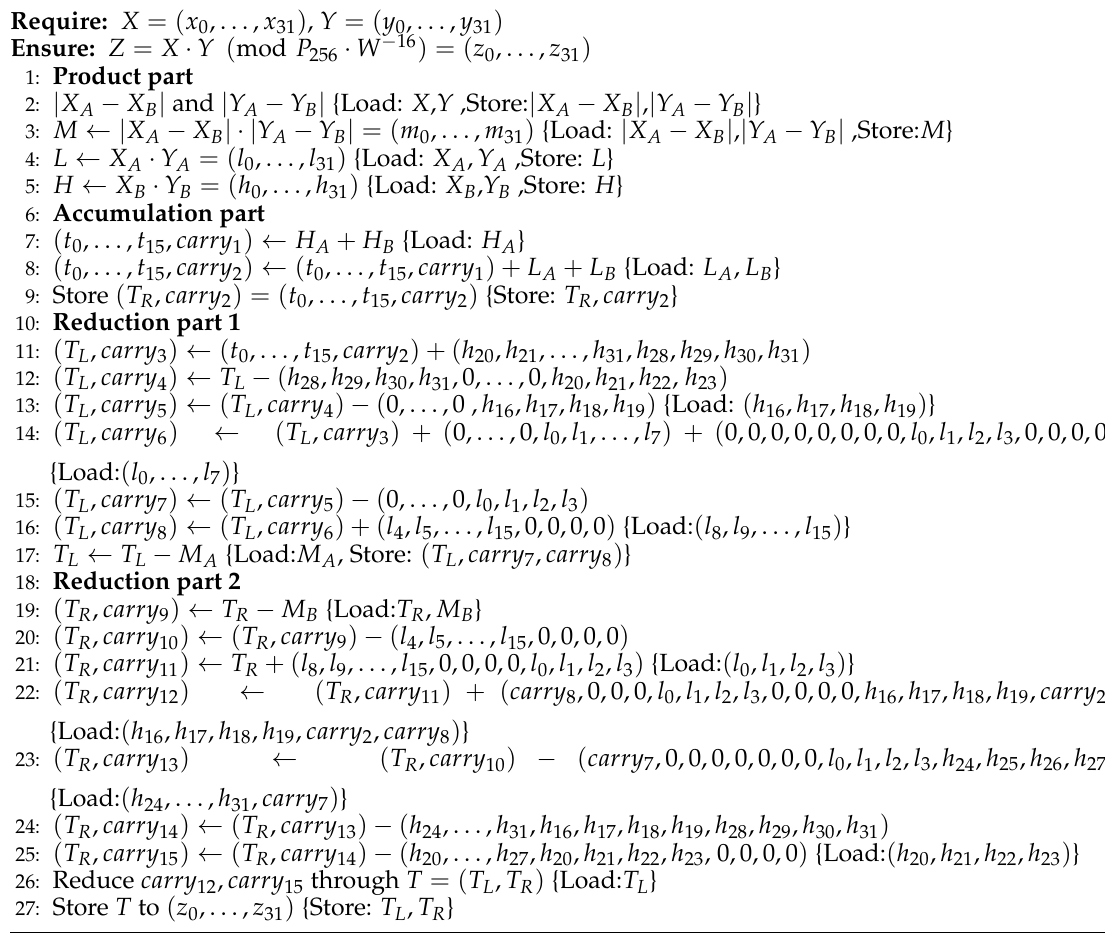
Algorithm 1 256-bit × 256-bit Karatsuba multiplication with reduction over F Require: X = ( x 0 , . . . , x 31 ) , Y = ( y 0 , . . . , y 31